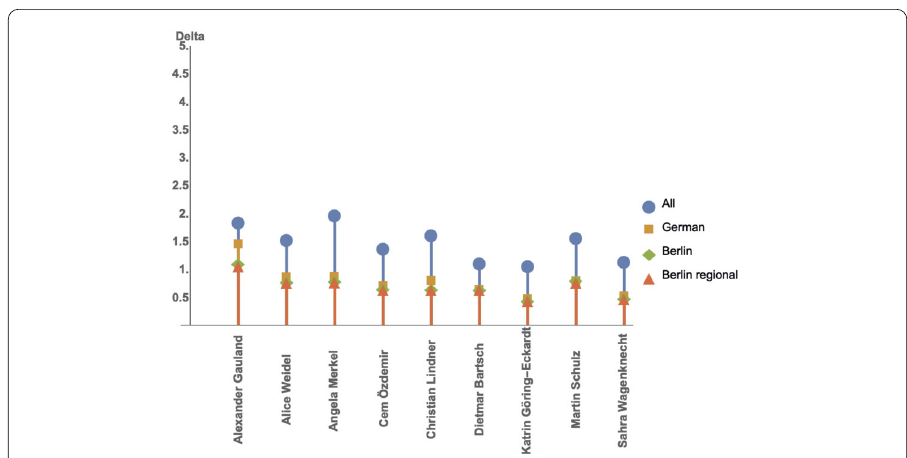
Figure 7 Similarity measure commons for persons: The space which is available for personalization is the difference (delta) between the average result list length and the average amount of commons per tuple for the parties in the respective data